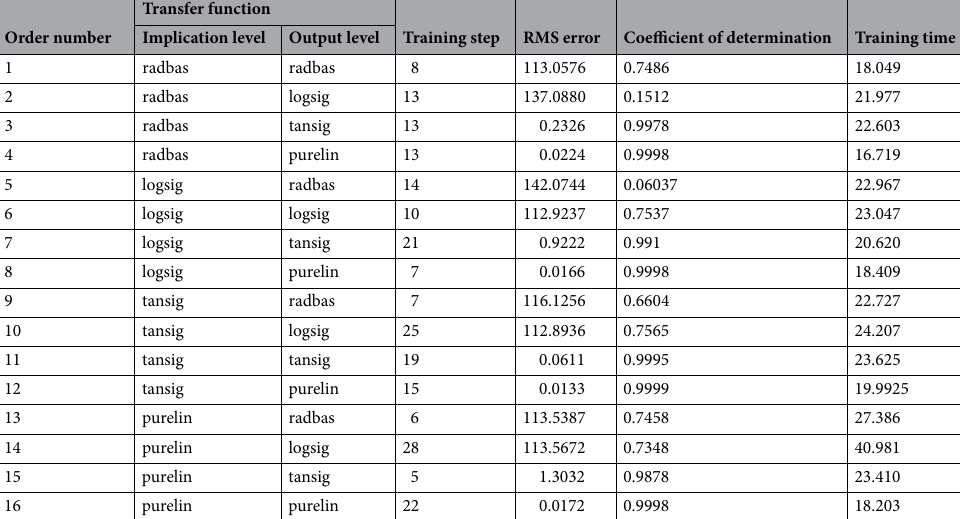
Table 1. The transfer function’s effect on the mode’s prediction